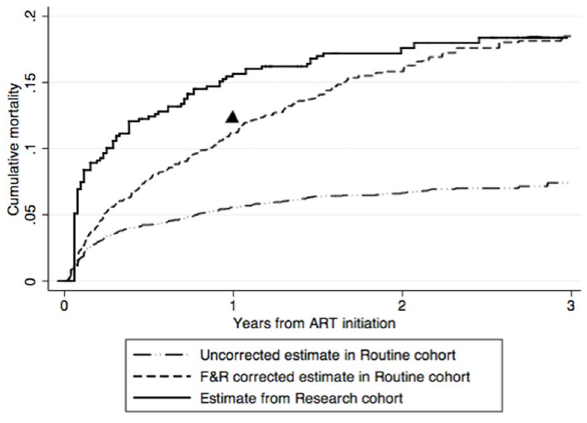
Figure 1. Uncorrected and F&R corrected cumulative mortality estimates in Routine and Research cohorts. The black triangle relates to the 1 st year mortality estimate obtained from the meta - analytic version of the nomogram